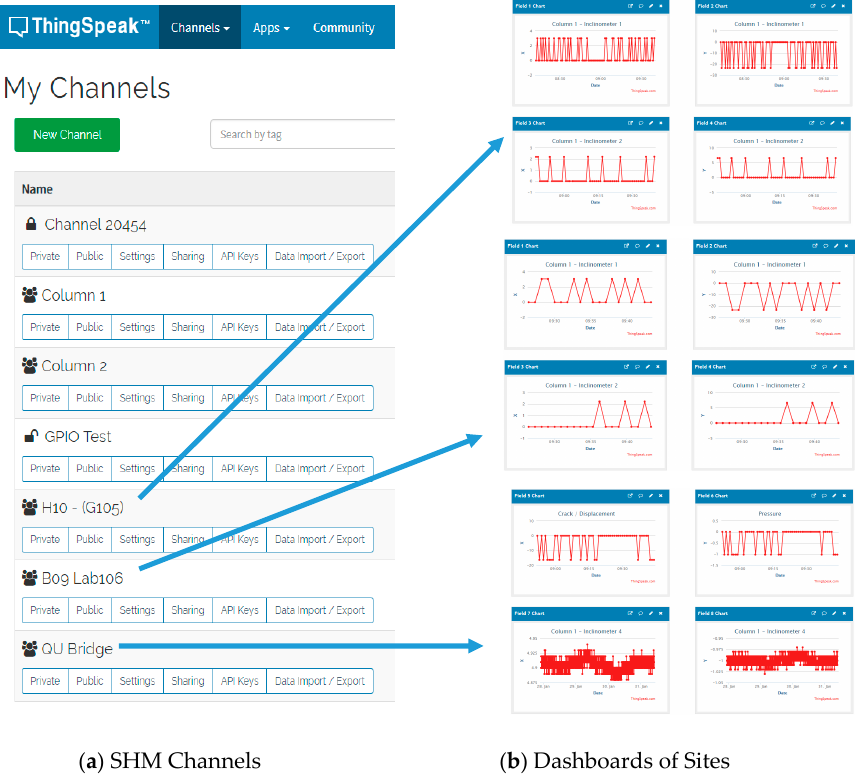
Figure 11. Public Cloud Data Source ThingSpeak IoT ( a , b ).